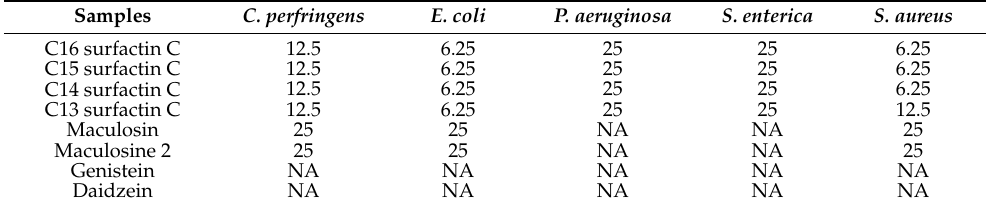
Table 2. MIC values of compounds 1–8 ( µ g/mL).